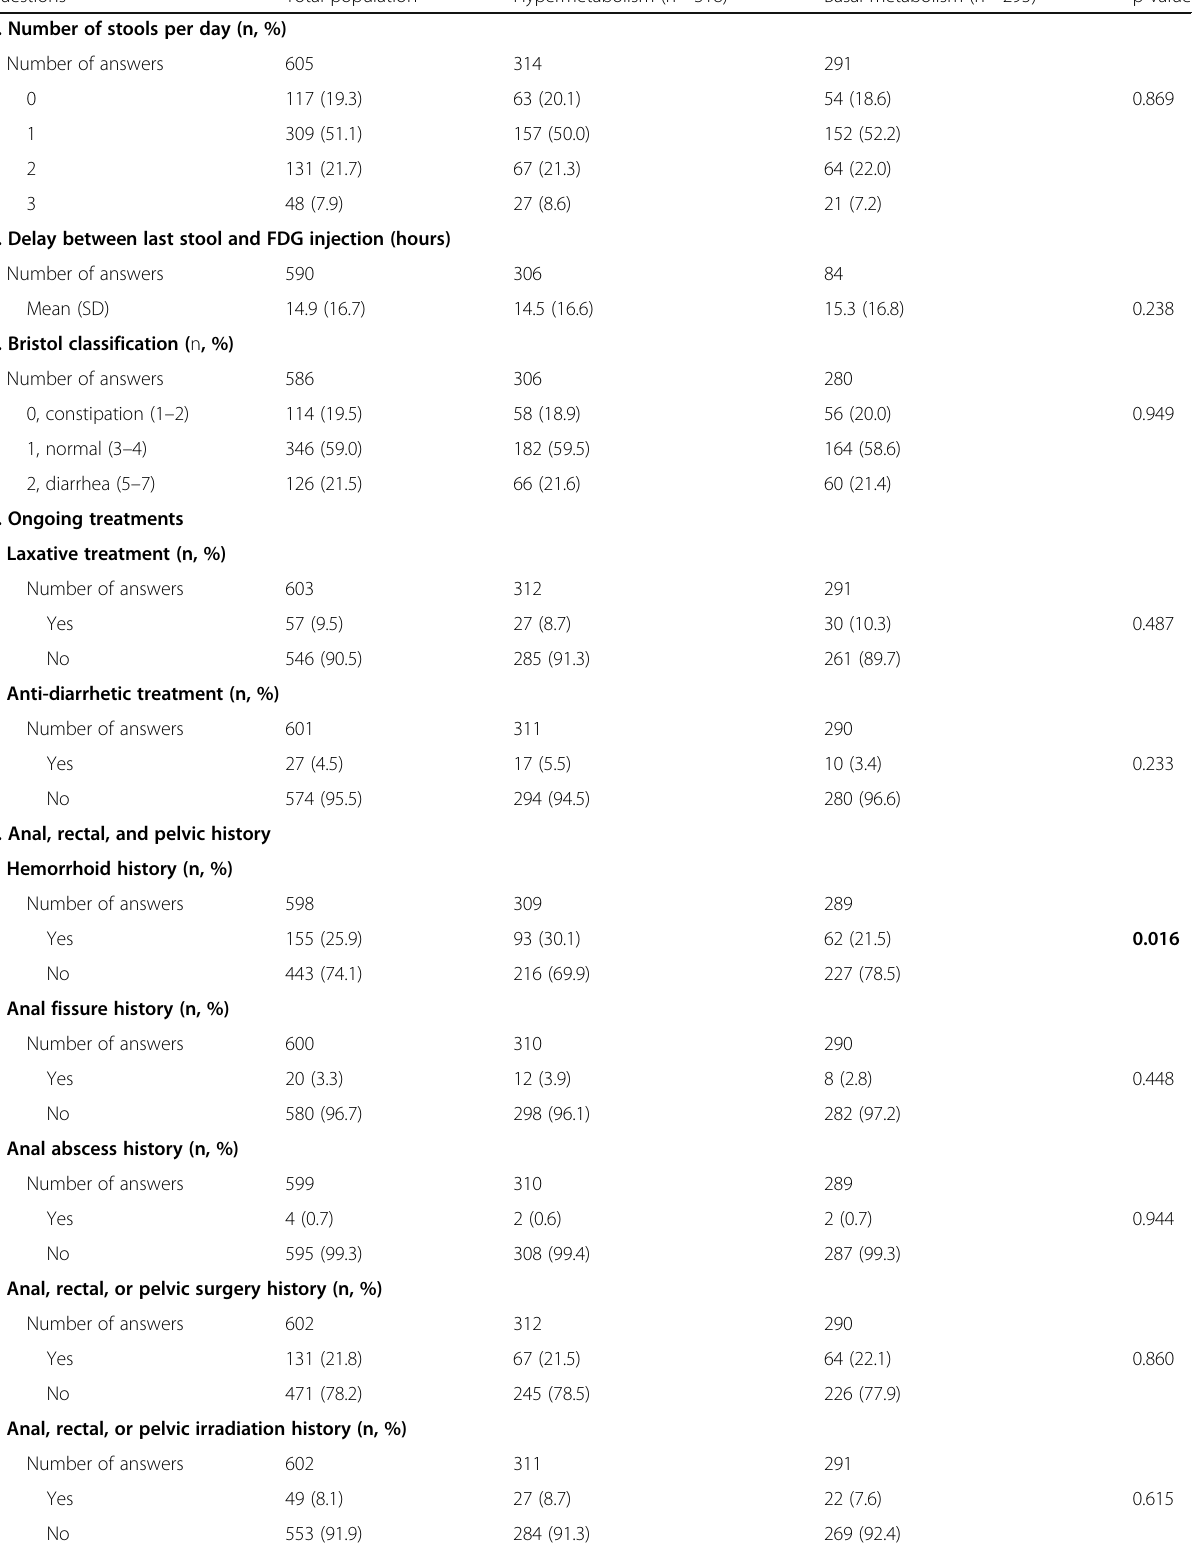
Table 2 Questionnaires